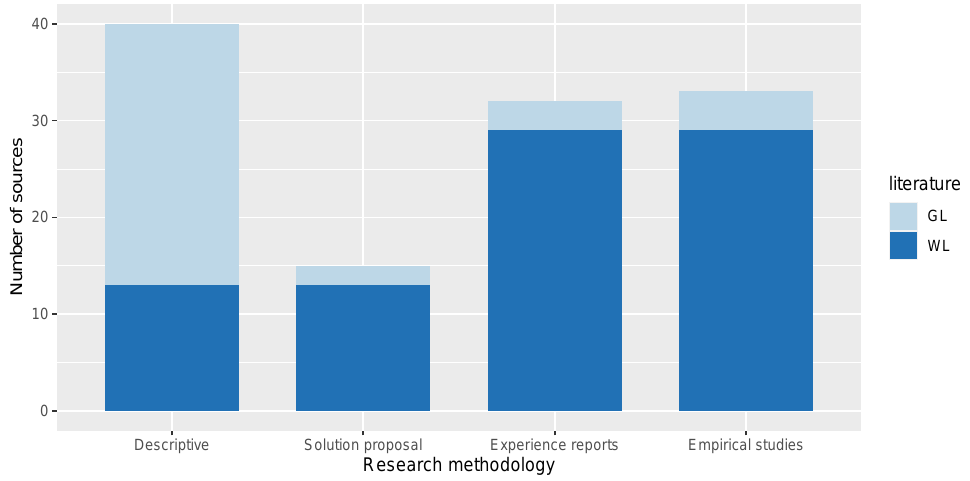
Figure 8. Number of papers by research methodology adopted.